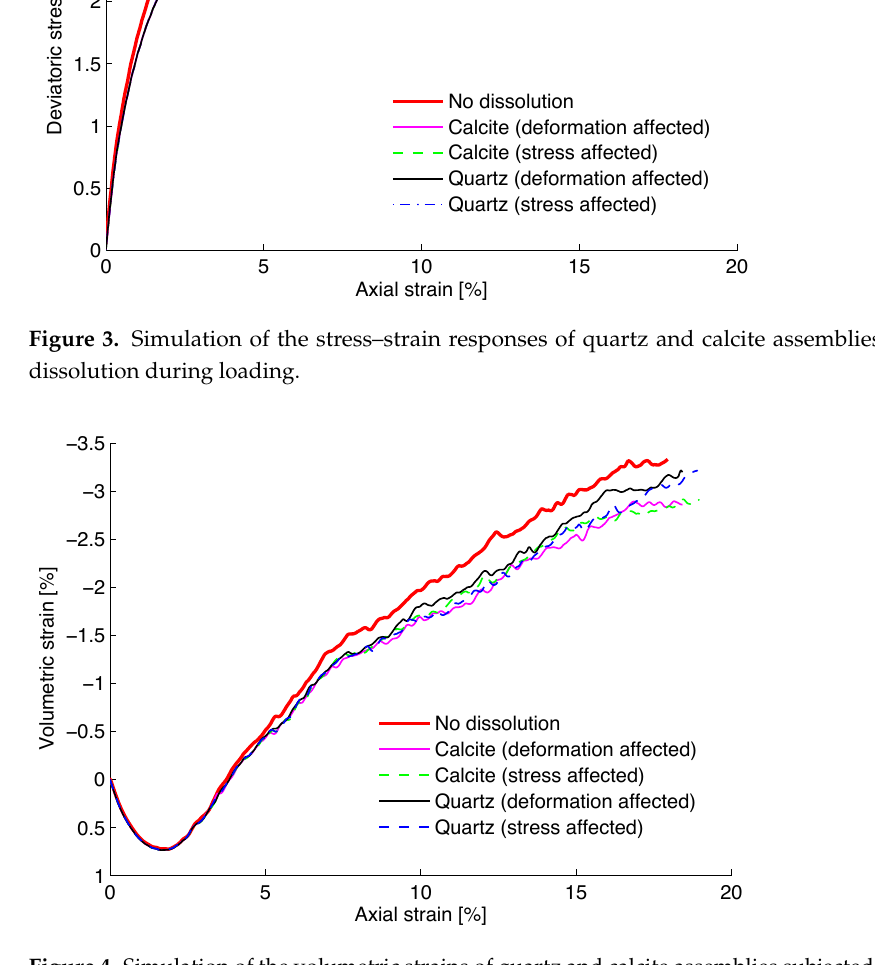
Figure 4. Simulation of the volumetric strains of quartz and calcite assemblies subjected to dissolution during